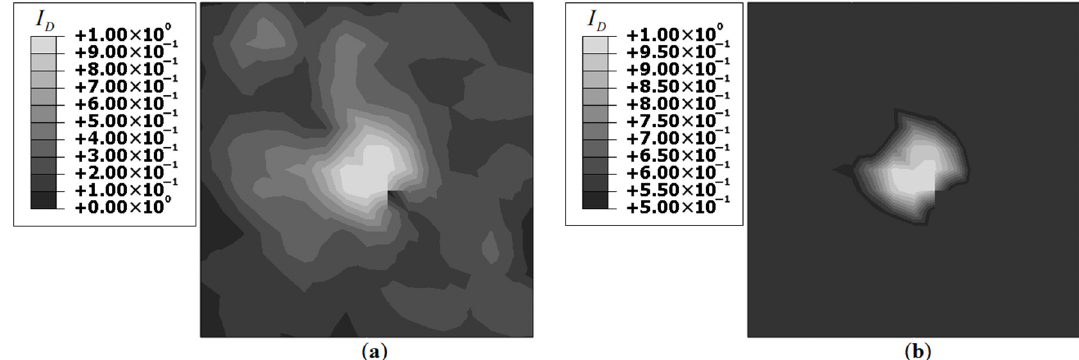
Figure 22. Benchmark iFEM results of 𝐼 (cid:3005) for Damage Case-3 (5% noise) using: ( a ) no threshold, and ( b ) threshold = 0.5.